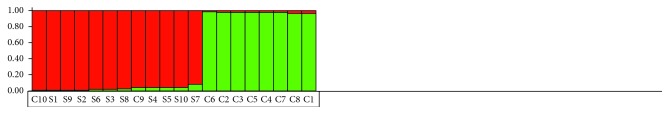
Bar plot of estimated membership probability (Q) for K = 2 for the SSR profiles of courguette ecotypes. Sample name are indicated on the X axis. The estimated membership probability (Q) for K = 2 is represented on the Y axis (C = Cilentano; S = San Pasquale).